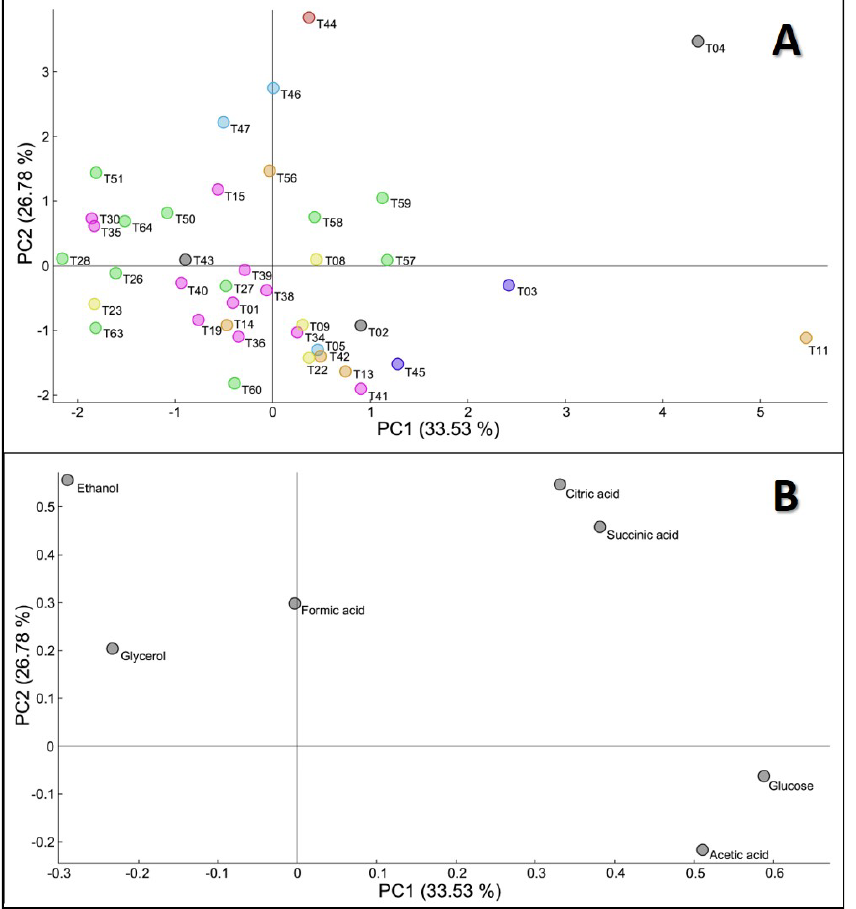
Figure 2. Principal component analysis of metabolic data of 40 T. delbrueckii strains. ( A ) Scores— 40 strains distribution. Colors represent the technological application or origin of the strains: • — unknown origin; ( B ) Loadings—concentration of seven metabolites obtained by HPLC analysis, after 192 h of